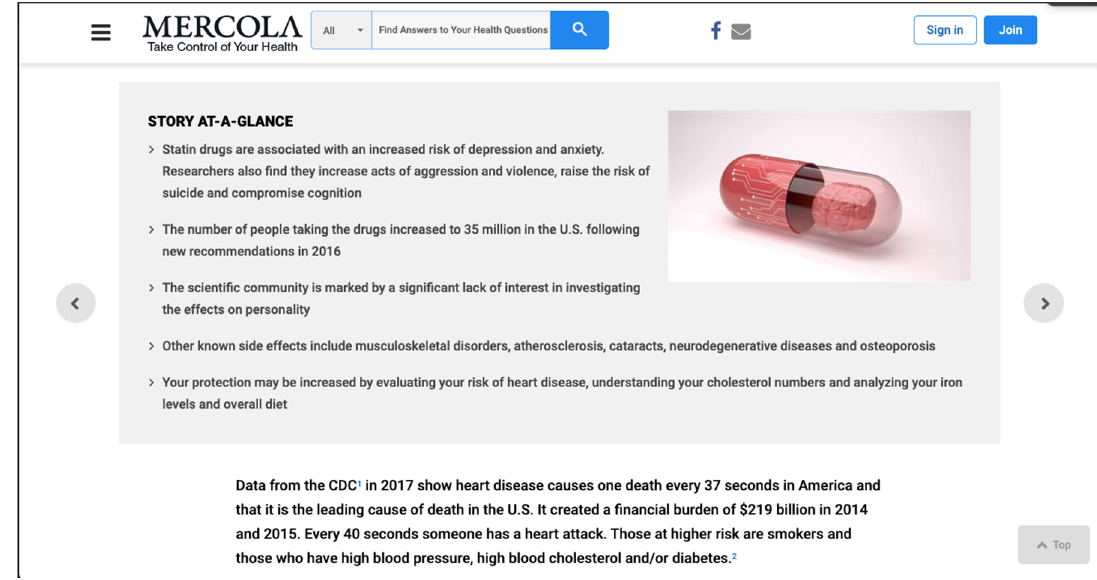
Figure 6. Dr. Joseph Mercola website article on statins